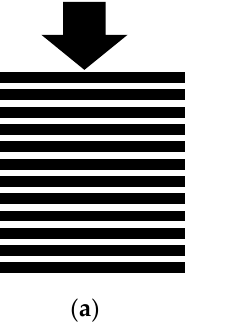
Figure 7. 3D-printed specimens with load direction of ( a ) 90° and ( b ) 0° to the layers [28].